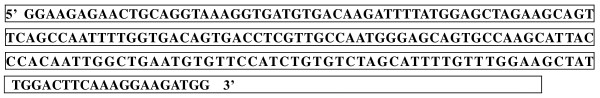
The conserved fragment of the nucleocapsid gene from TGEV.